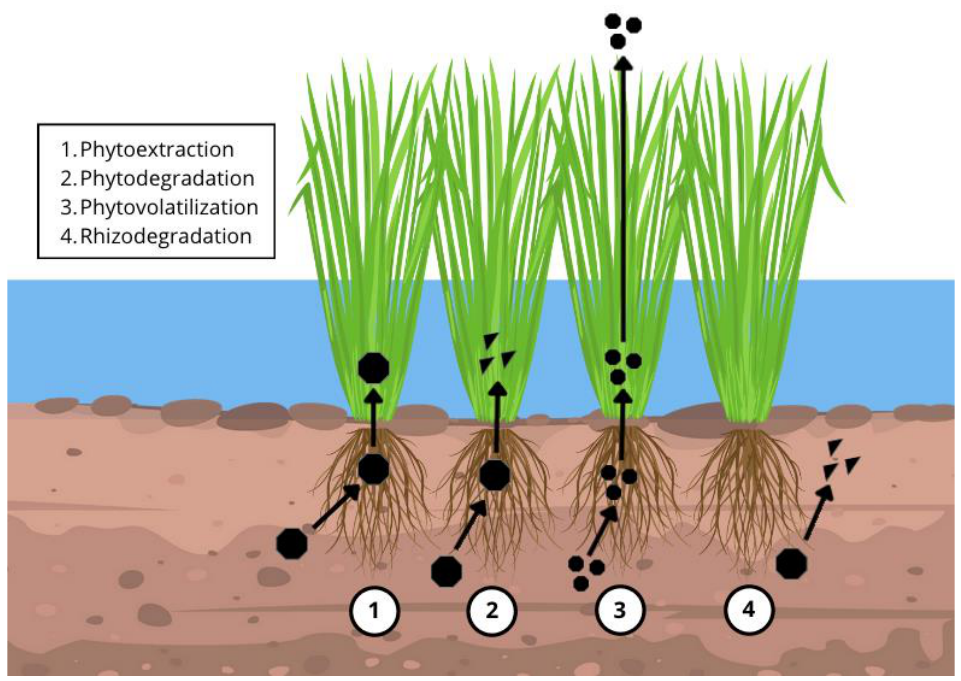
Figure 4. Types of phytoremediation for emerging contaminants in wetlands. Octagons represent parent compounds, triangles represent transformation